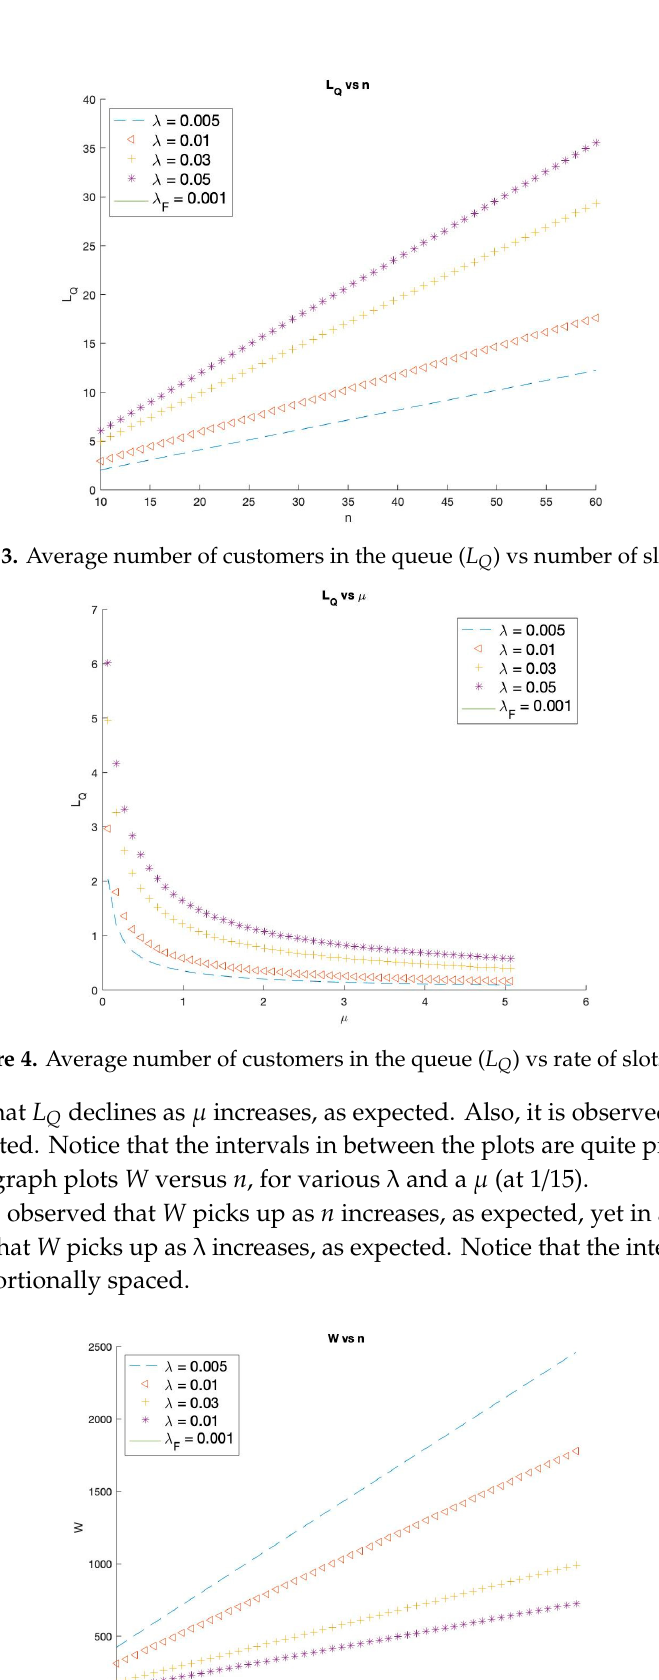
Figure 5. Average amount of time in system ( W ) vs number of slots ( n ).